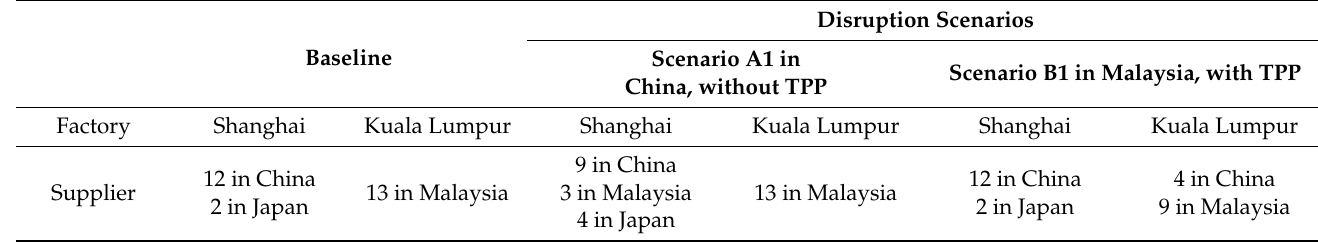
Table 4. Selection of suppliers and factories in scenarios A1 and B1.